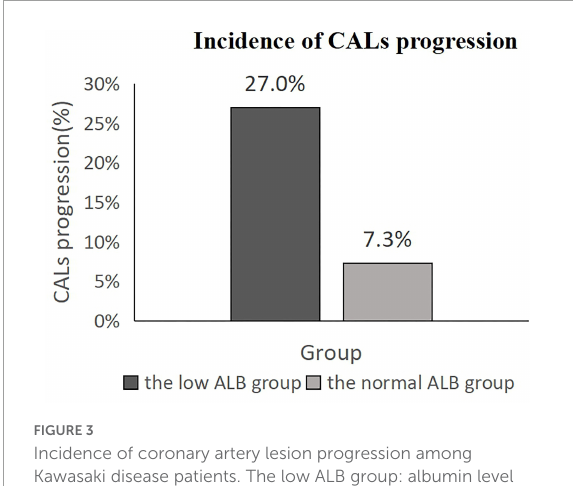
TABLE 2 Independent effect of ALB level on CALs progression among Kawasaki disease patients.